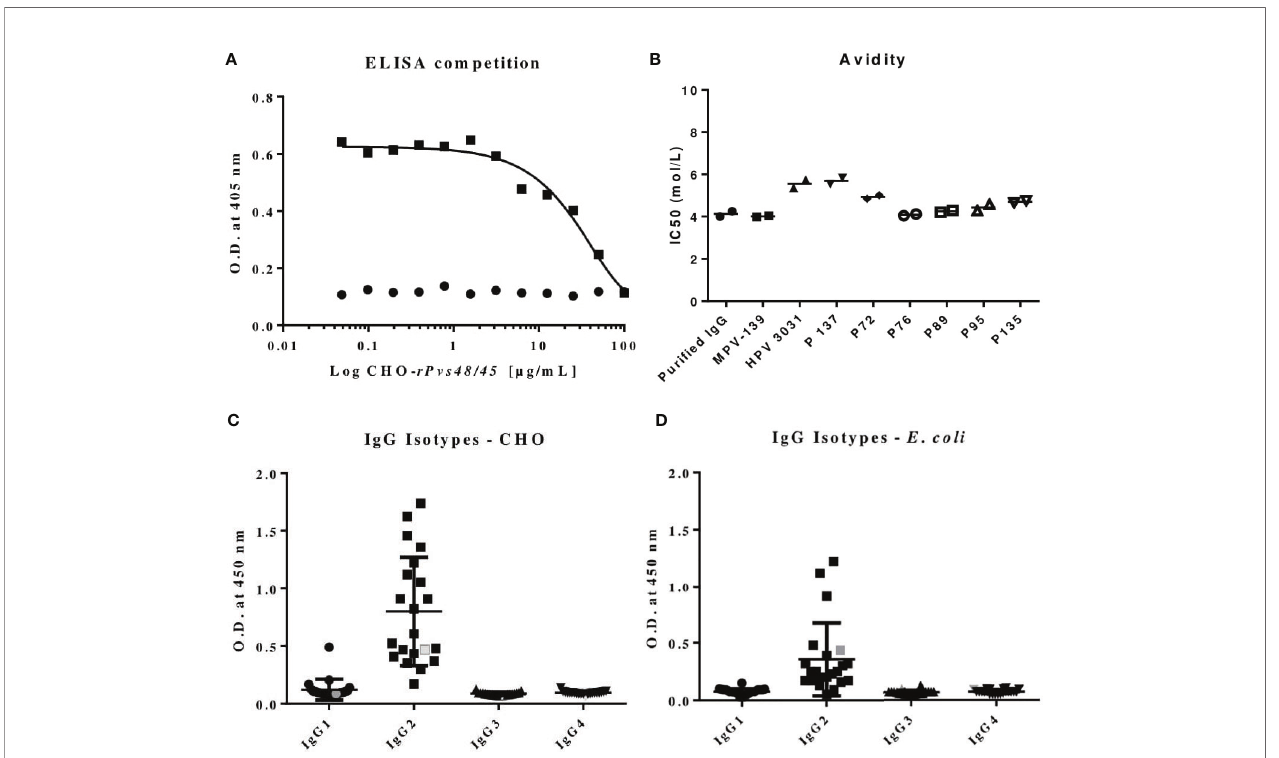
FIGURE 3 | (A) ELISA competition assay for the af fi nity-puri fi ed CHO- rPvs 48/45-speci fi c human IgG ( ▪ ) and normal IgG ( (cid:129) ) against CHO- rPvs 48/45 protein. Plates were coated with CHO- rPvs 48/45 recombinant protein (1 m g/mL) and then a test IgG (10 m g/mL) was incubated together with the recombinant protein at different concentrations (0 to 100 m g/mL). (B) The IC50 mean of puri fi ed IgG and sera samples were determined by ELISA with increasing urea concentration (from 0 to 7 mol/L). The serum samples were selected for presenting the highest reactivity index (RI>5) of the sampling location: MPV 139 (Tierra Alta), HPV 3031 and P 137 (Buenaventura), and P72 (Quibdo ́ ) and reactivity index between 2-4: P76, P89, P95, P135 from the same regions. Anti-IgG1, IgG2 IgG3, and IgG4 subclasses are reported as OD mean of COL plasma samples (black symbols) randomly chosen and puri fi ed CHO- rPvs 48/45-speci fi c human IgG (grey symbols) using plates coated with either CHO- (C) or E. coli-rPvs 48/45 (D) protein.